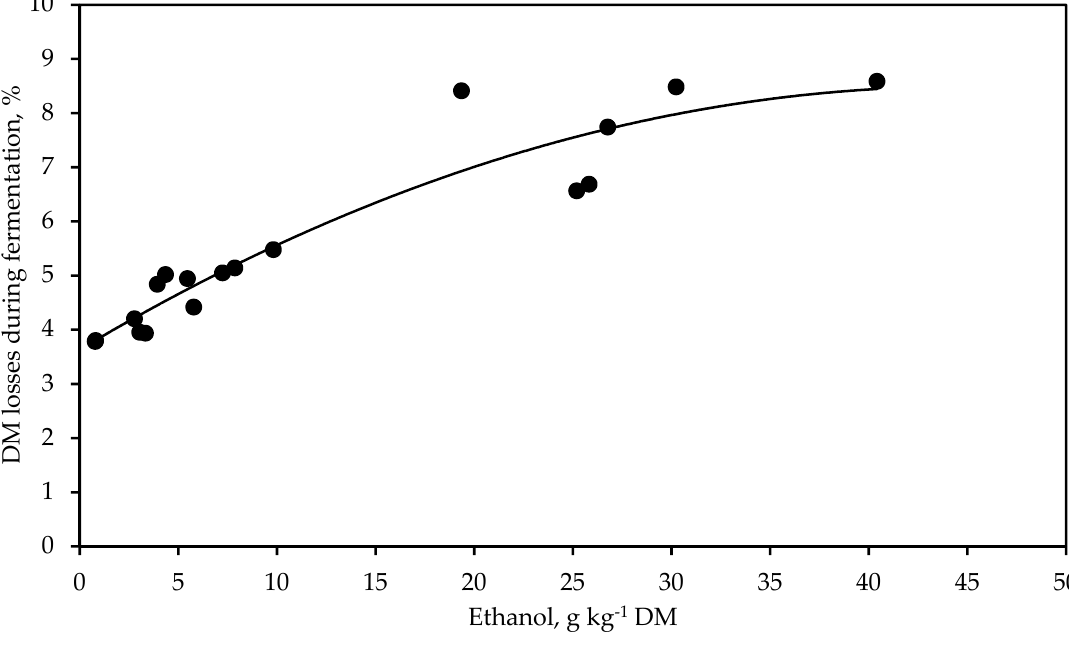
Figure 1. Relationship between the concentration of ethanol and the dry matter (DM) losses during fermentation in whole-crop rye silage treated with di ff erent additives and stored for 53 days. Y = 3.63 + 0.217x − 0.0024x 2 , R 2 = 0.88, RMSE = 0.58, p < 0.001, n = 18.